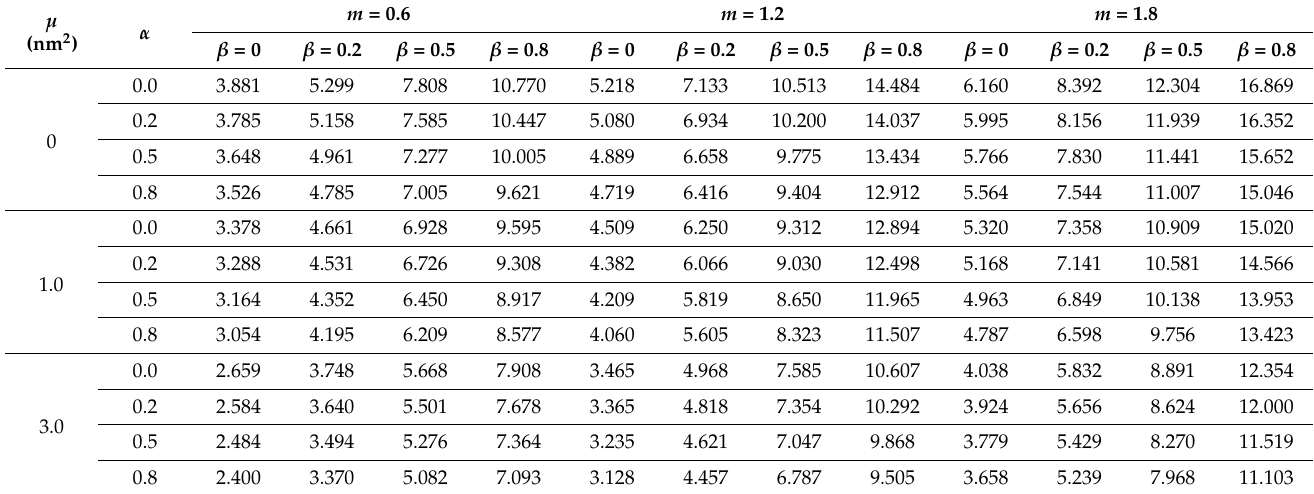
Table 5. Effect of the power-law exponent and tapering parameter on the normalized flexural–torsional buckling load ( P nor ) of simply supported thin-walled nanobeams with different nonlocal parameters (axial load applied on the TF at x = l